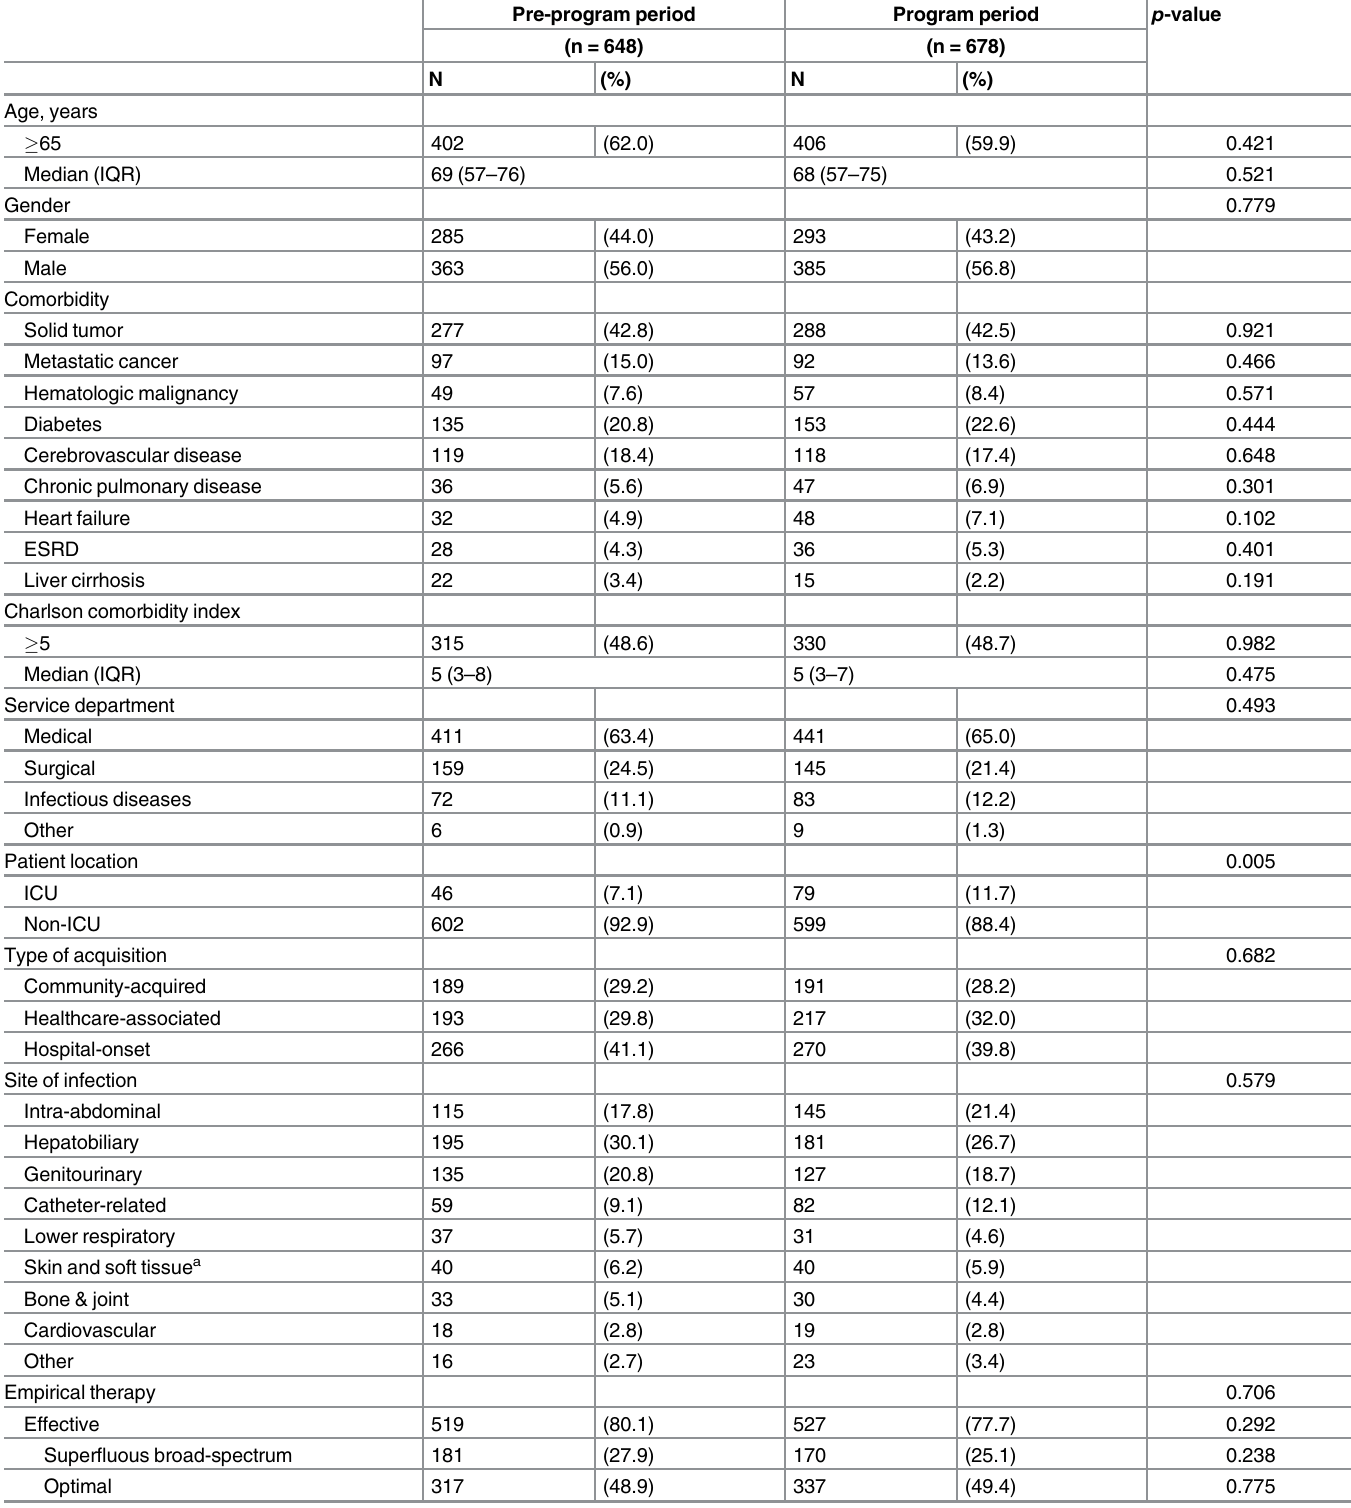
Table 1. Clinical characteristics of bloodstream infection episodes in the pre-program and program